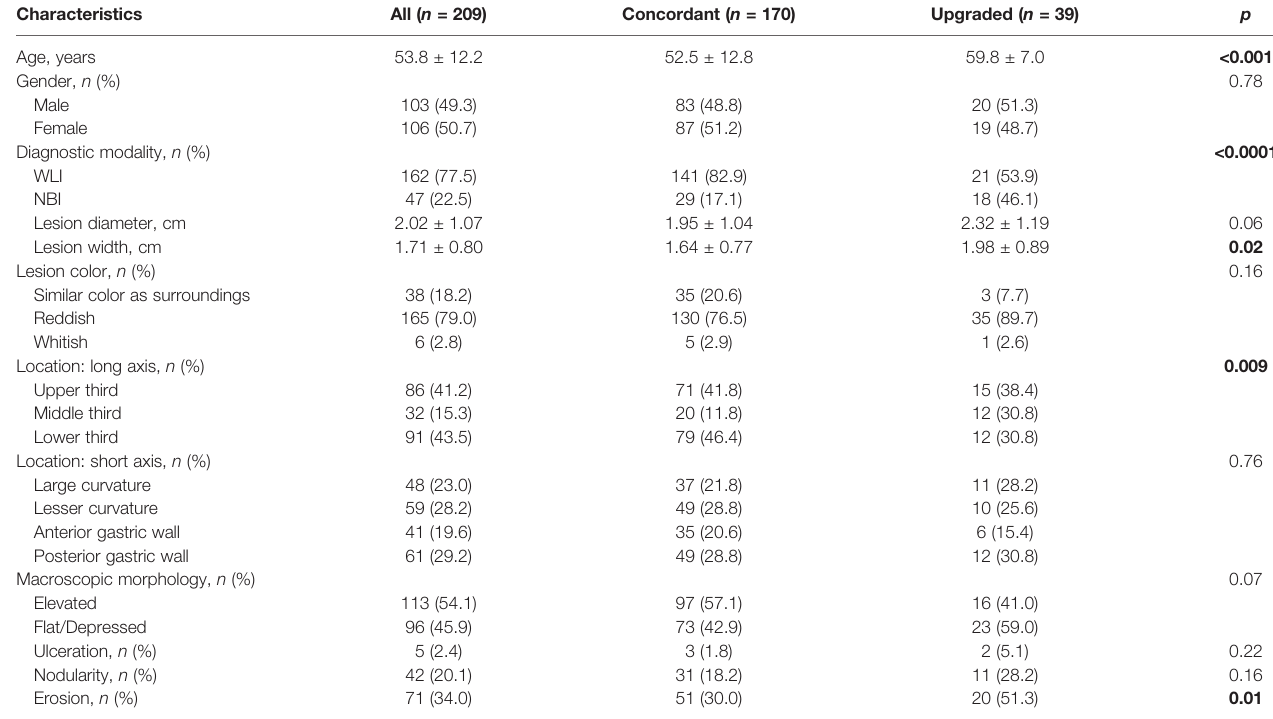
TABLE 1 | Characteristics of the study patients between concordant and upgraded groups.